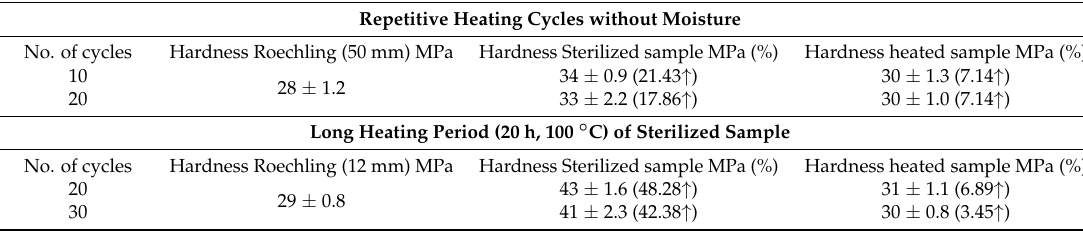
Table 3. Effect of heating without moisture on the hardness of Roechling PEEK test